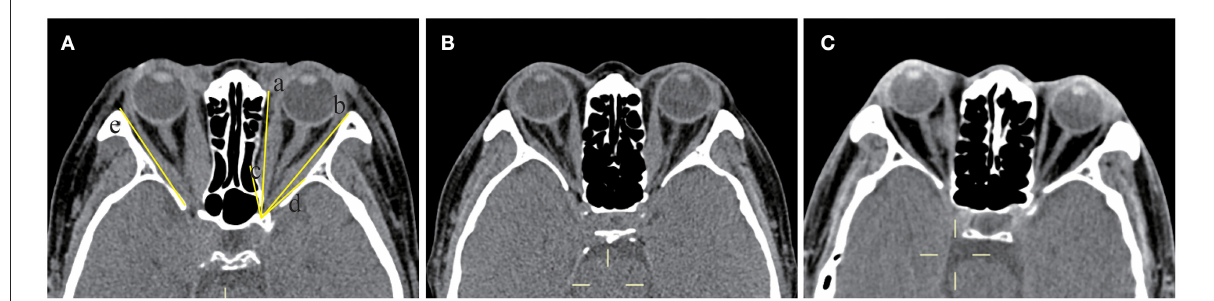
FIGURE1 Computed tomography (CT) images at the axial section of bony orbital angles measurement. (A) The orbit with DON, which labels the measurement of the bony orbital angles. The orbital rim angle (ORA) was measured at the level of the medial canthus ligament, measuring the angle (degrees) between two lines, with line a drawn along the margin of the medial orbital wall and line b connecting the frontozygomatic process and the most medial portion of the inner border of the sphenoid wing with extension intracranially until it intercepts with line a. The same axial section containing the bulk of the medial and lateral rectus muscles showed the medial wall angle (MWA) between lines a and c, the lateral wall angle (LWA) between lines b and d, and the orbital apex angle (OAA) between lines c and d. The length of the lateral orbital wall (LWL) was measured on the section just inferior to the anterior clinoid (labeled line e). (B) The orbit without DON. (C) The orbit of the normal control (right eye).